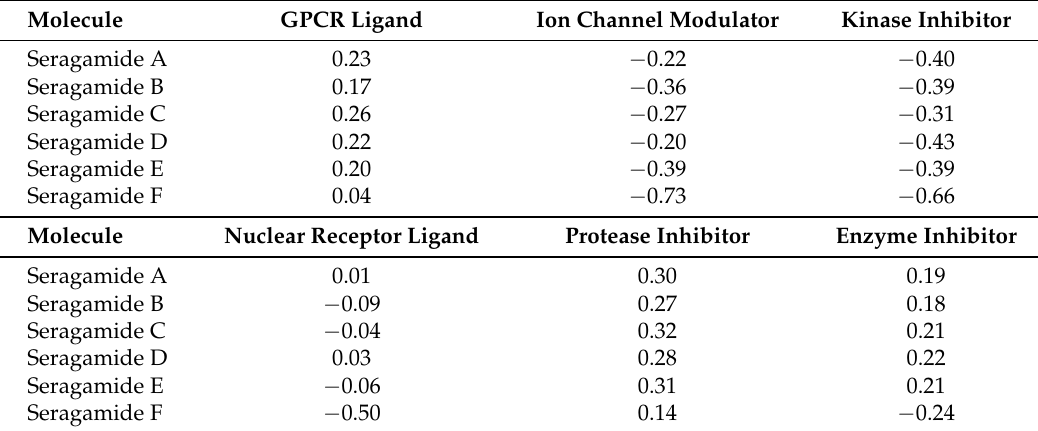
Table 5. Bioactivity Scores of Seragamides A–F calculated on the basis of GPCR ligand, ion channel modulator, nuclear receptor kigand, kinase inhibitor, protease inhibitor and enzyme inhibitor